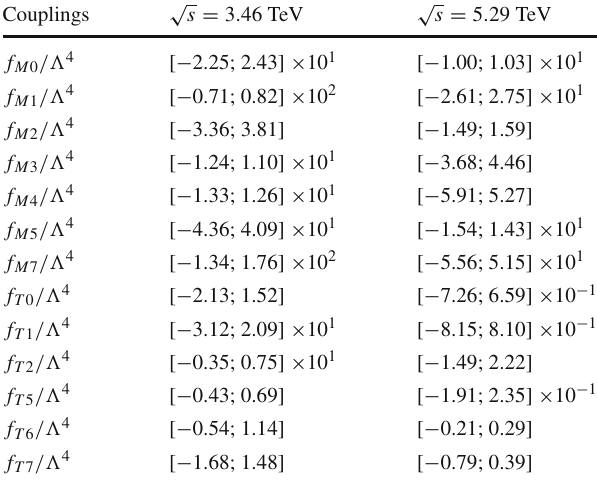
Table 8 Sensitivity measures on the aQGC at the 95% C. L. via the √ s = 3.46, process e − p → e − γ ∗ p → pW − γν e at the FCC-he with 5.29 TeV and 1000 f b − 1 for the combined data. Here, we consider that only one of the anomalous couplings deviates from the SM at any given time √ √ s = 3 . 46 TeV s = 5 . 29 TeV Couplings